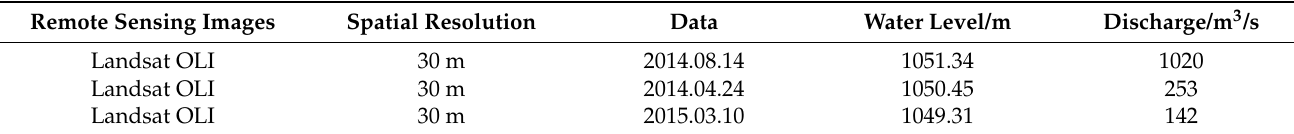
Table 1. Water levels and discharges for the three analysed Landsat images.